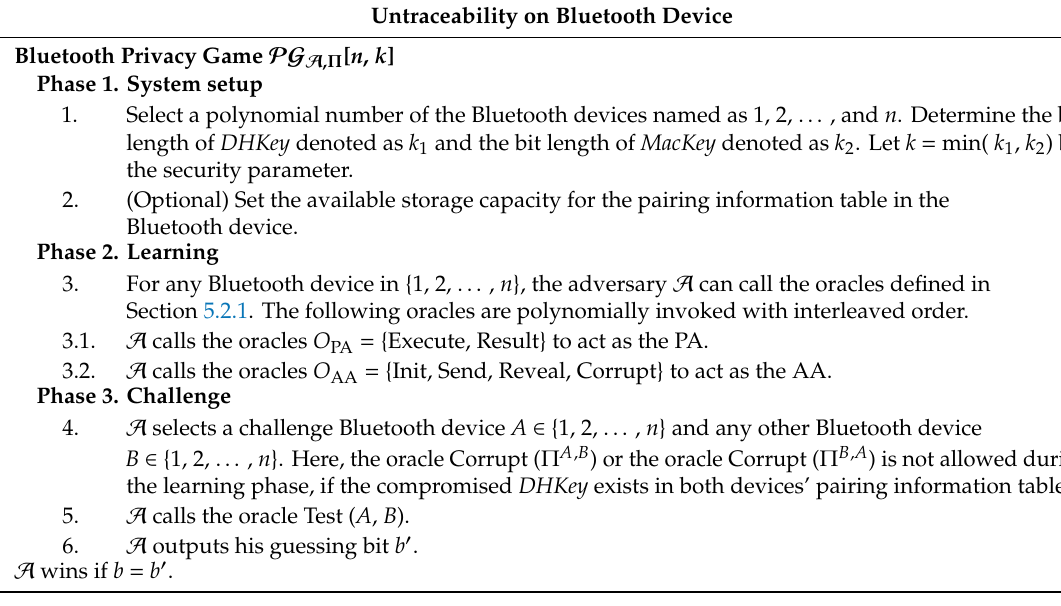
Table 2. Bluetooth privacy game for the LESSP-type